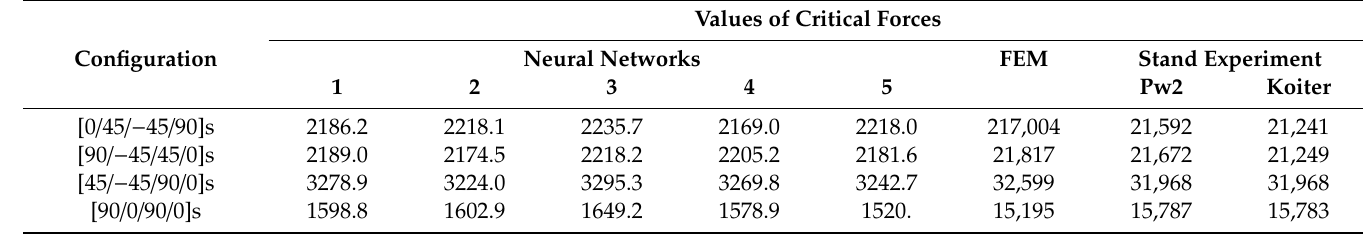
Table 5. The values of the critical buckling forces predicted by the artificial neural networks with the values obtained using the finite element and experimental